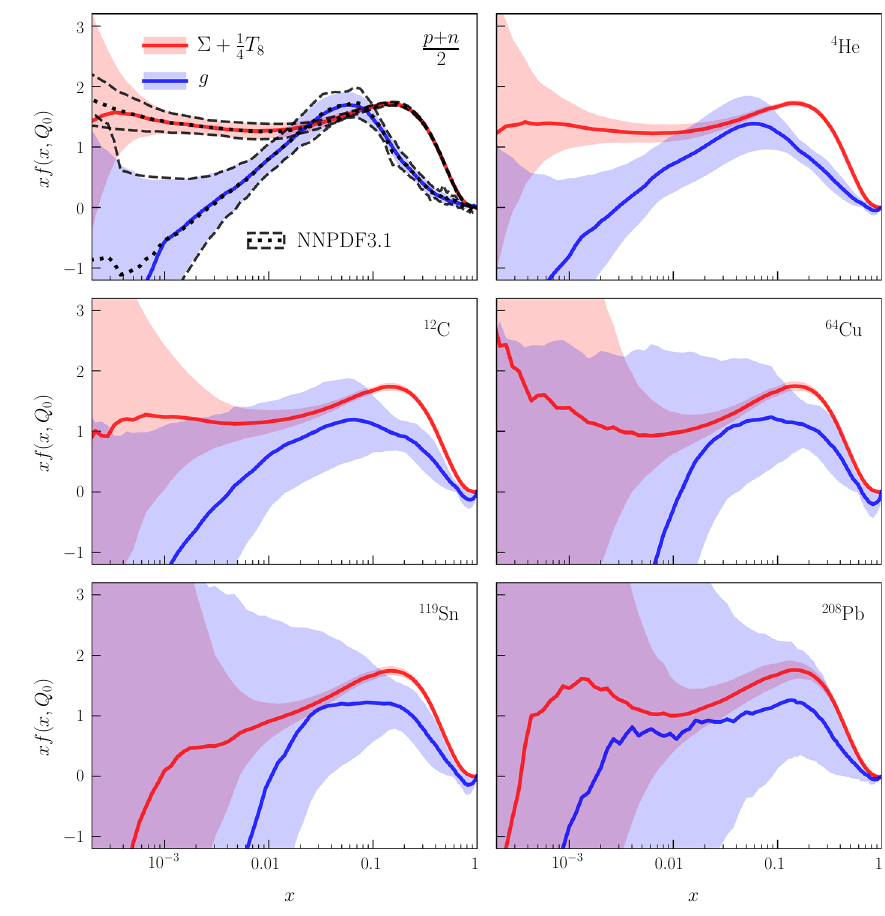
Fig. 16 The nNNPDF1.0 NLO set as a function of x at the input scale Q 0 = 1 GeV for different values of A . We show the central value for the gluon g (solid blue line) and the quark combination (cid:12) + T 8 / 4 (solid red line) for A = 1 (isoscalar nucleon), A = 4 (He), A = 12 (C), A = 64 (C), A = 119 (Sn), and A = 208 Pb. The corresponding uncertainties (shaded bands) correspond to the 90% confidence level intervals. In the case of A = 1 we also show the central value of the baseline free-nucleon PDF set, NNPDF3.1 (black dotted line), and its uncertainties (black dashed